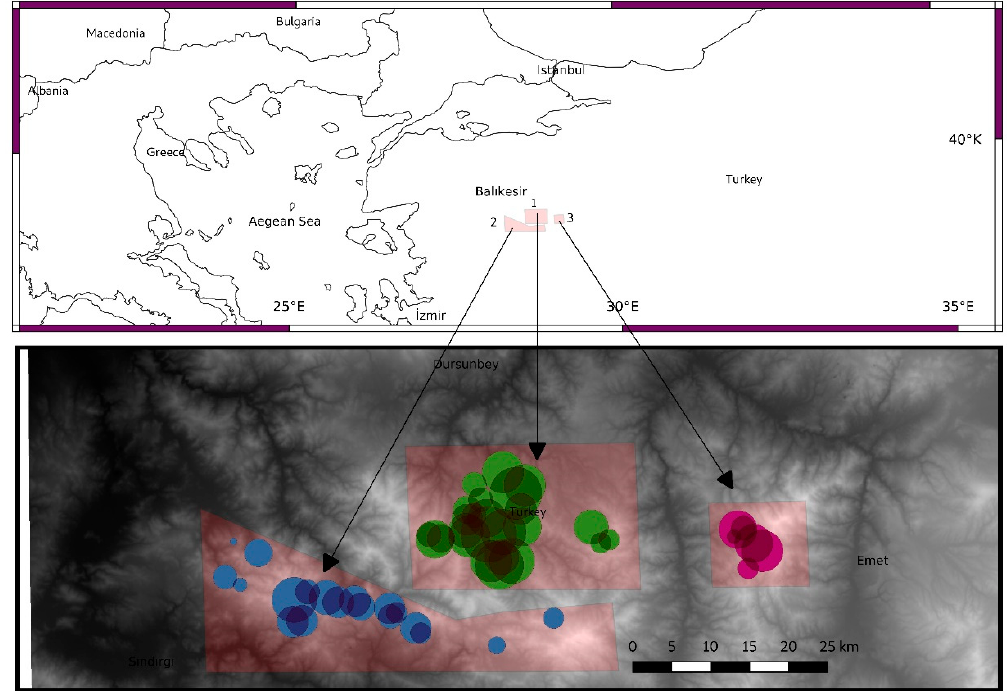
Figure 1. Location of the three study regions (1: Dursunbey, 2: Sındırgı, 3: Simav) of Pinus nigra forest stands in the Alaçam Mountains (top). The richness of each sampling plot is represented by the sizes and colors of circles, which represent different study regions (bottom).